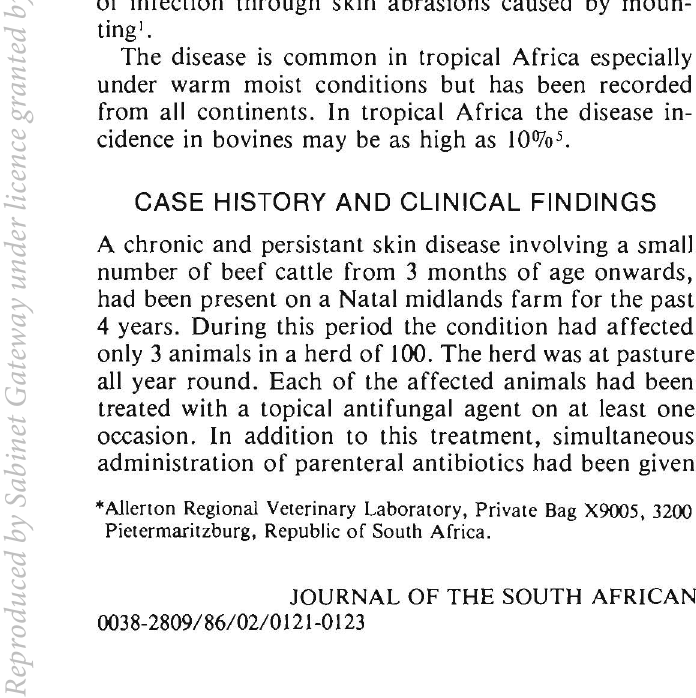
Fig. 1: Appearence of skin on presentation of bovine.